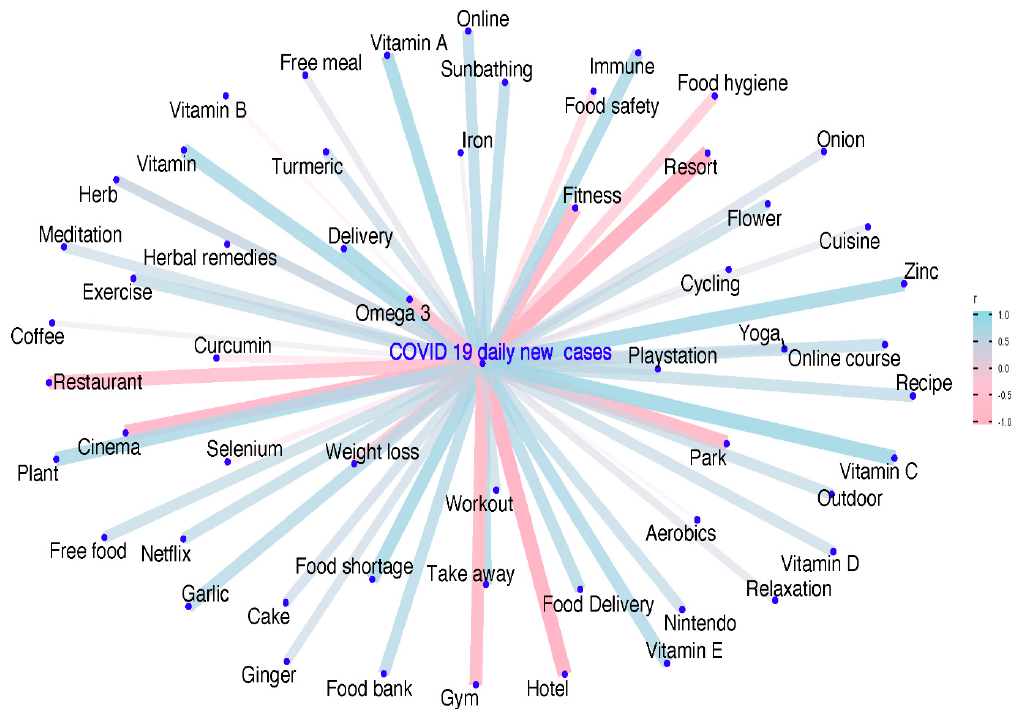
Figure 4. Global network correlations between daily conformed COVID-19 cases and diet-related lifestyle behavior search terms. The size of the nodes represents the strength of the correlation between the daily confirmed COVID-19 cases and diet-related lifestyle behavior search terms denoted as relative search volumes (RSVs). Each path represents a correlation, and the wider and less transparent the path, the stronger the correlation between the two variables. Blue indicates a positive correlation, while red represents a negative correlation.